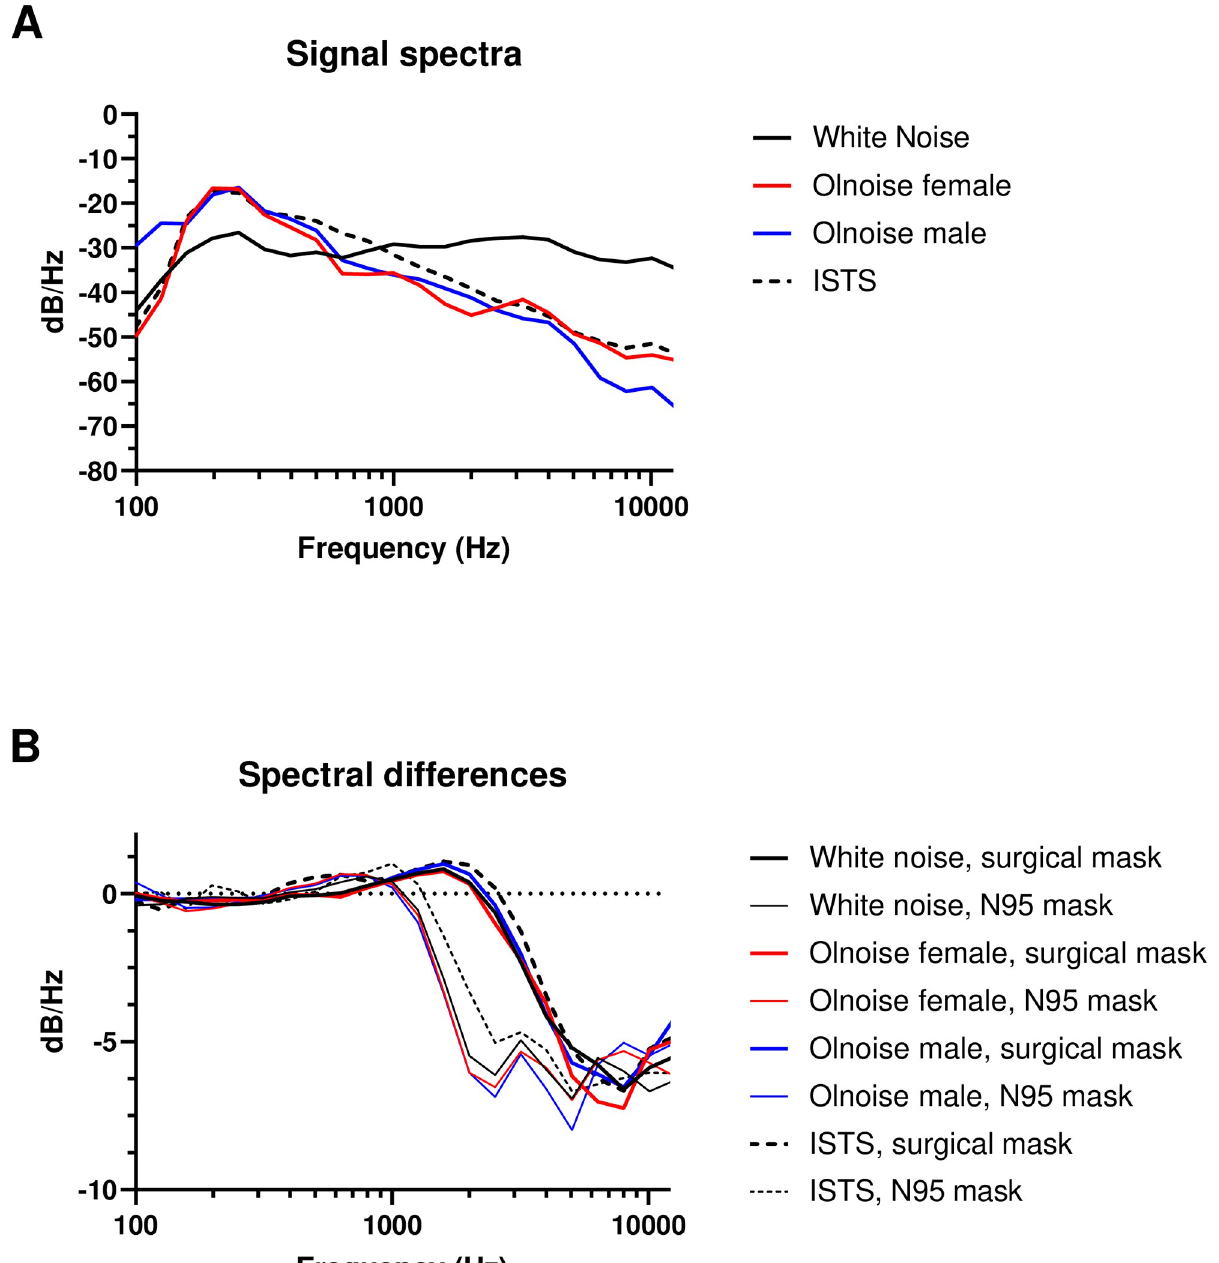
Fig 4. A. 1/3-octave amplitude spectra of the dummy head recordings for white noise (black line), ISTS (dashed line), Olnoise female (red line), and Olnoise male (blue line) noise signals presented without a mask. B. Spectral differences in recordings with a surgical mask (bold lines) or an N95 mask (thin lines) for all used noise signals compared with the unmasked recordings. At frequencies above 1 kHz, some mask tissue reduced the amplitudes by up to 8 dB. A surgical mask reduced the amplitudes at frequencies above 2 kHz, but a reduction was already measurable at frequencies already above 1 kHz for the N95